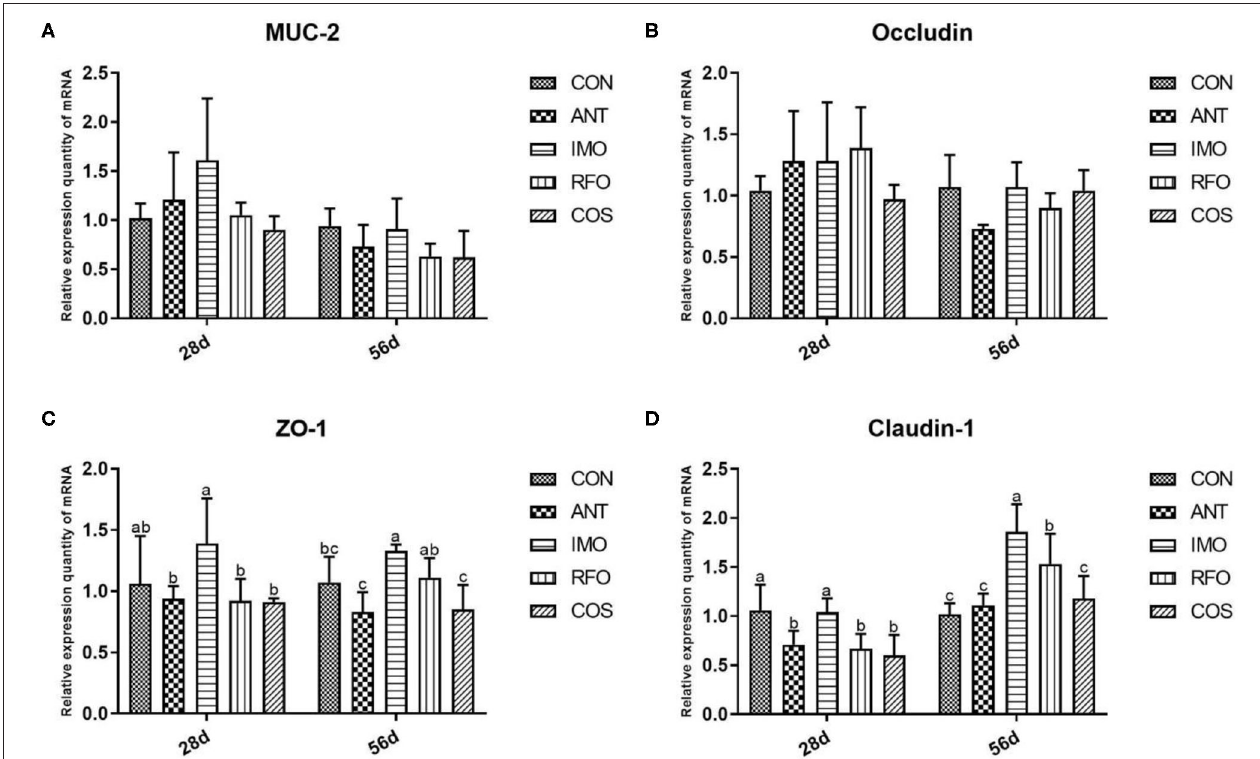
FIGURE 2 | Effects of different treatments on the expression of intestinal related genes and the immune function of ileum in broilers ( n = 6). (A) MUC-2, (B) occludin, (C) ZO-1, and (D) claudin-1. Graph bars marked with different letters on top represent statistically significant results ( p < 0.05) based on ANOVA with Duncan’s range tests. CON, control group; ANT, ANT group; IMO, IMO group; RFO, RFO group; COS, COS